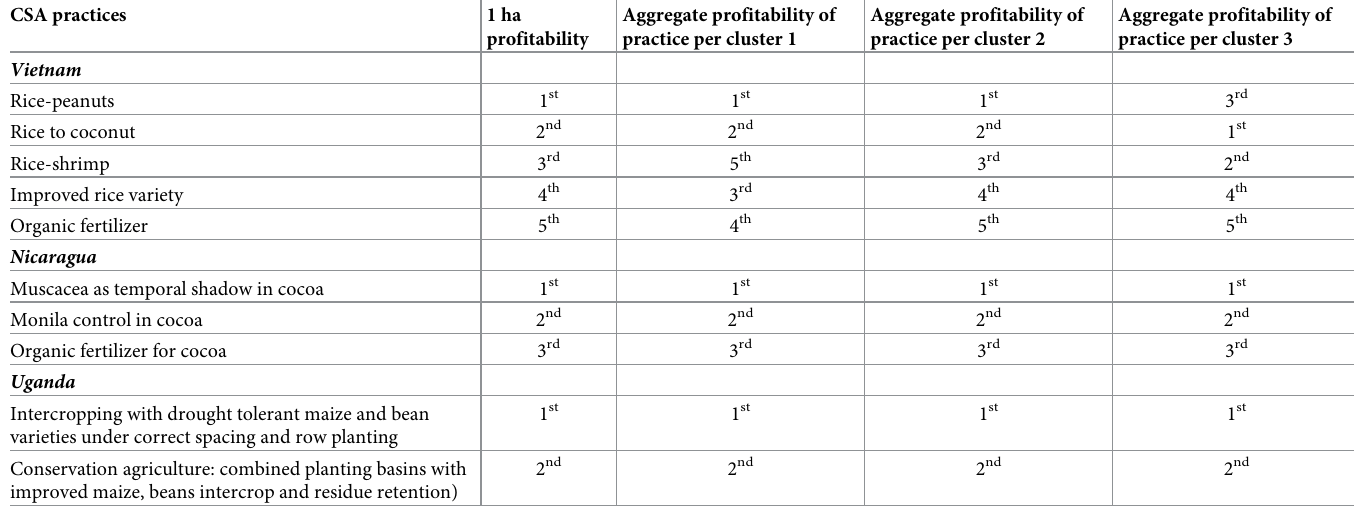
Table 8. Comparison of ranking of CSA practices between farm profitability and aggregate